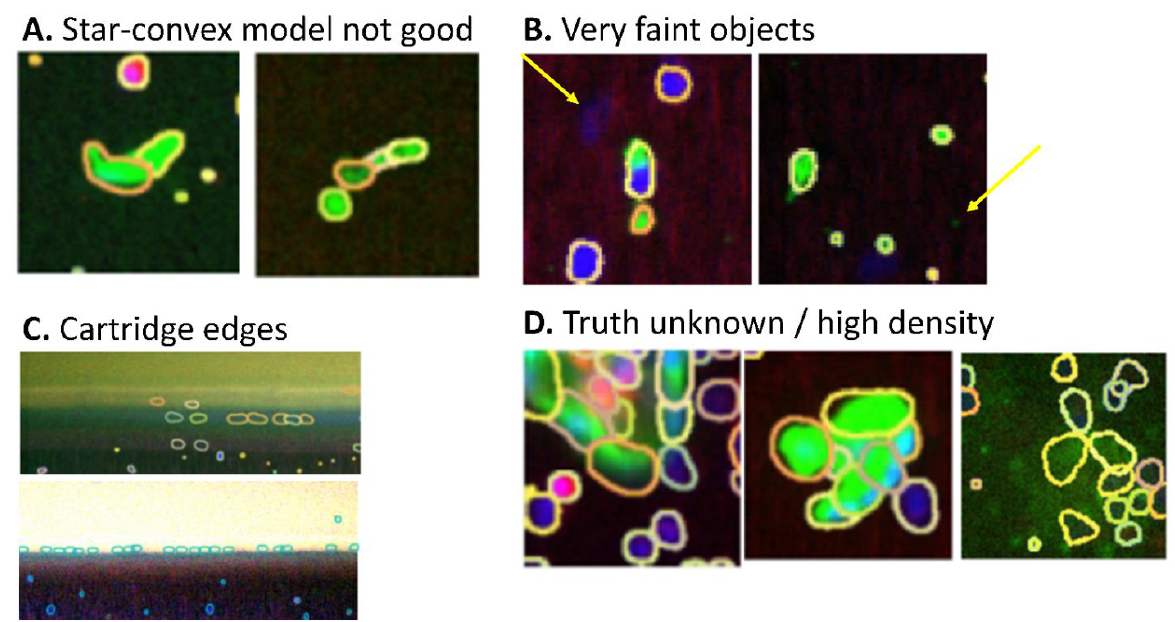
Figure 7. Limitations of StarDist segmentations and unknown truth. ( A ) Non-star-convex shapes cannot be segmented properly by StarDist. ( B ) Some very faint objects are not segmented. ( C ) Car- tridge edges can lead to segmentation artifacts in StarDist. ( D ) Examples of images where the ‘true’ segmentation is unknown.